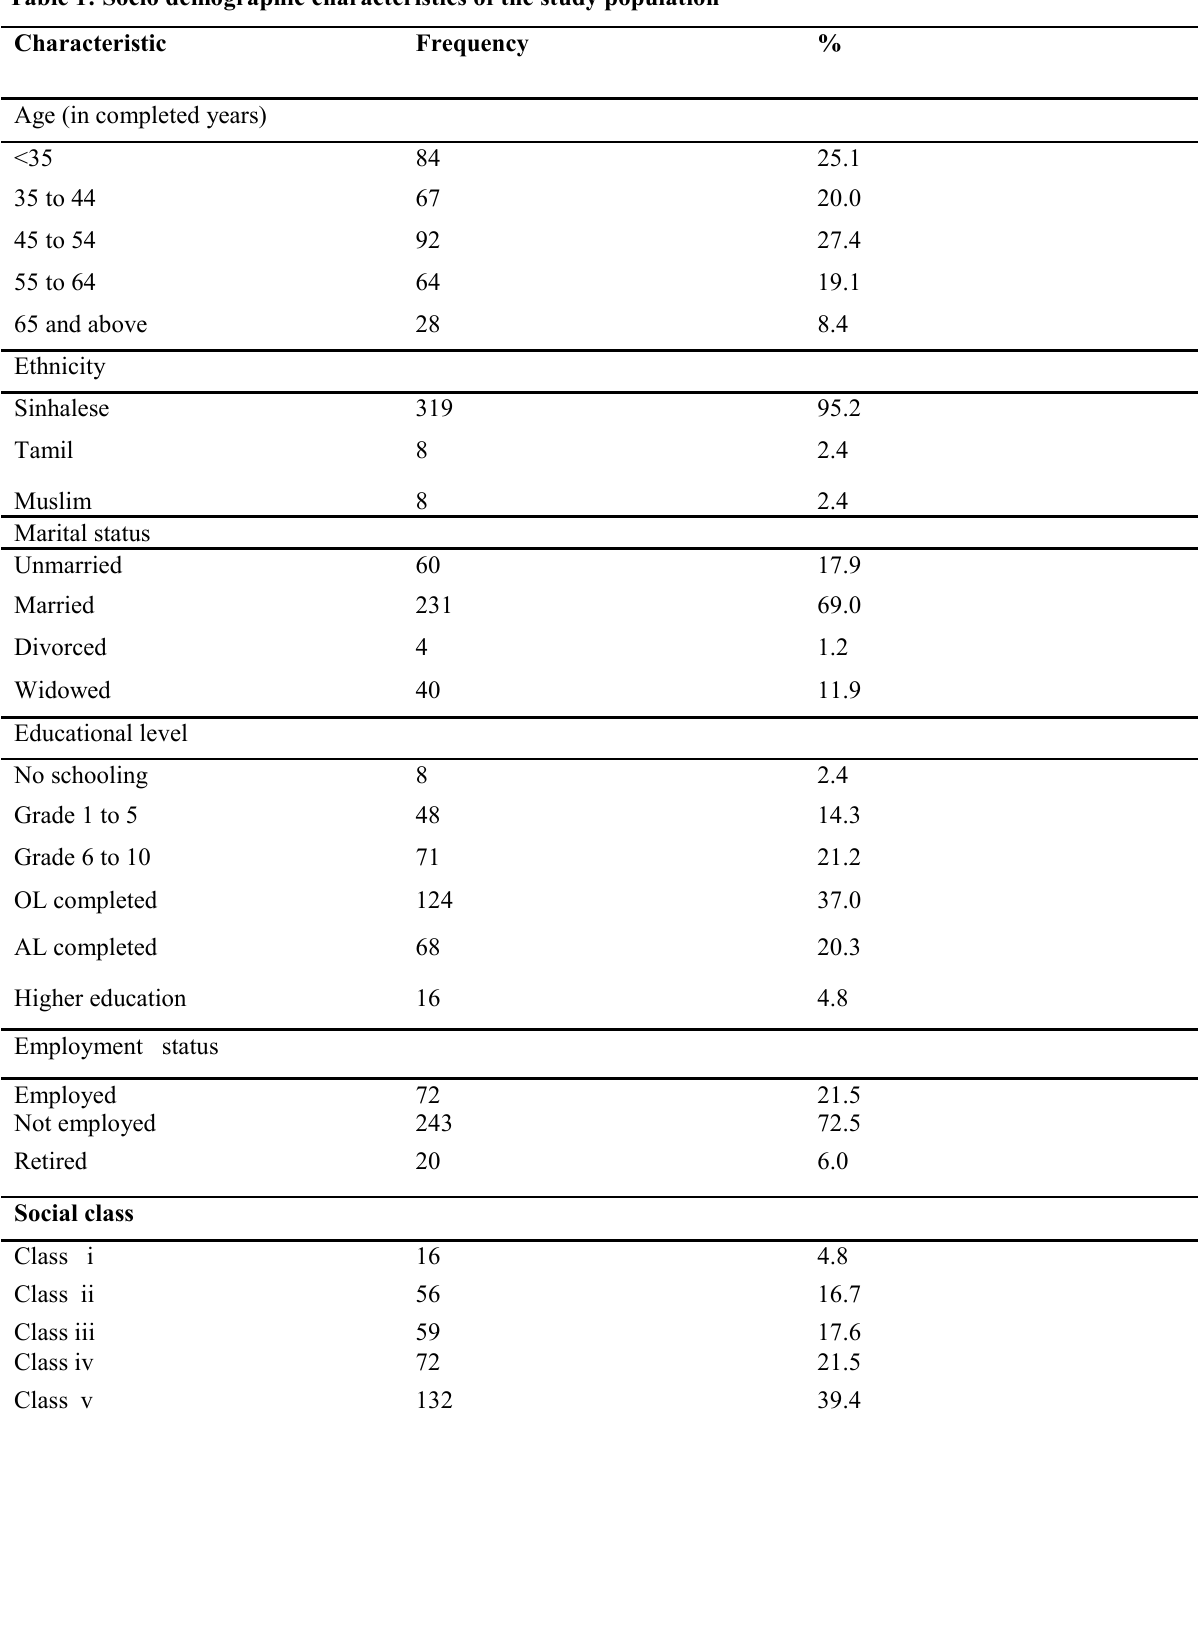
Table 1: Socio demographic characteristics of the study population